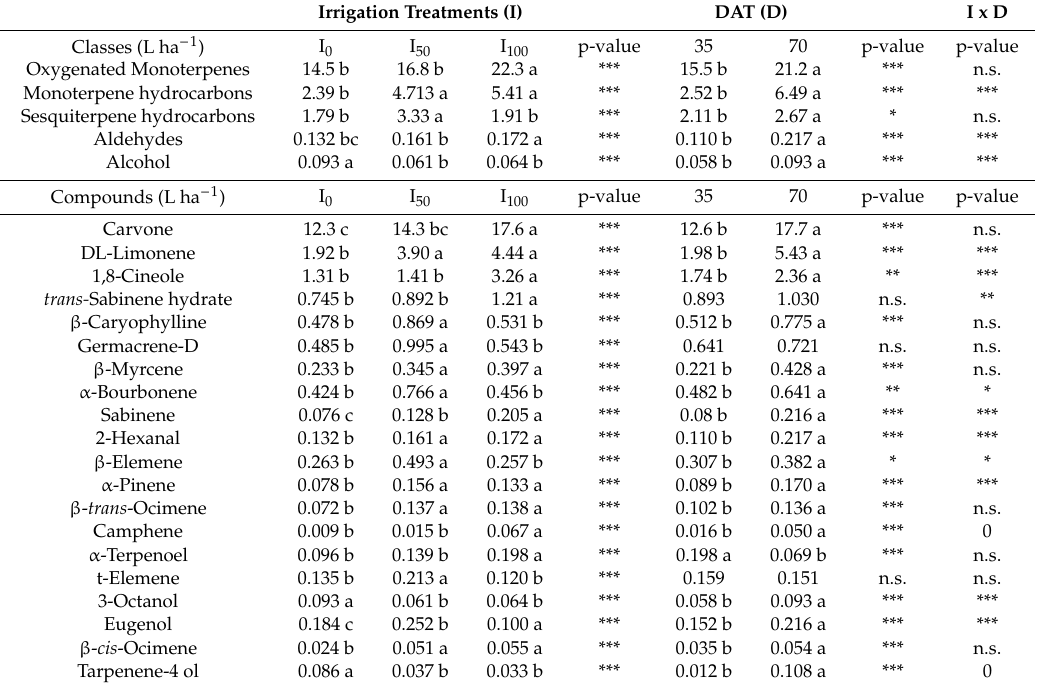
Table 3. The essential oil yield of spearmint plants (L ha − 1 ) under di ff erent irrigation treatments (I 100 , I 50 and I 0 ) at two dates (DAT 35 and 70). Statistical analysis was performed by two-way ANOVA and Tukey test for mean di ff erences. P-value *** means significant at 0.001; ** means significant at 0.01; * means significant at 0.05. Means followed by the same letter are not significatively di ff erent at 5%